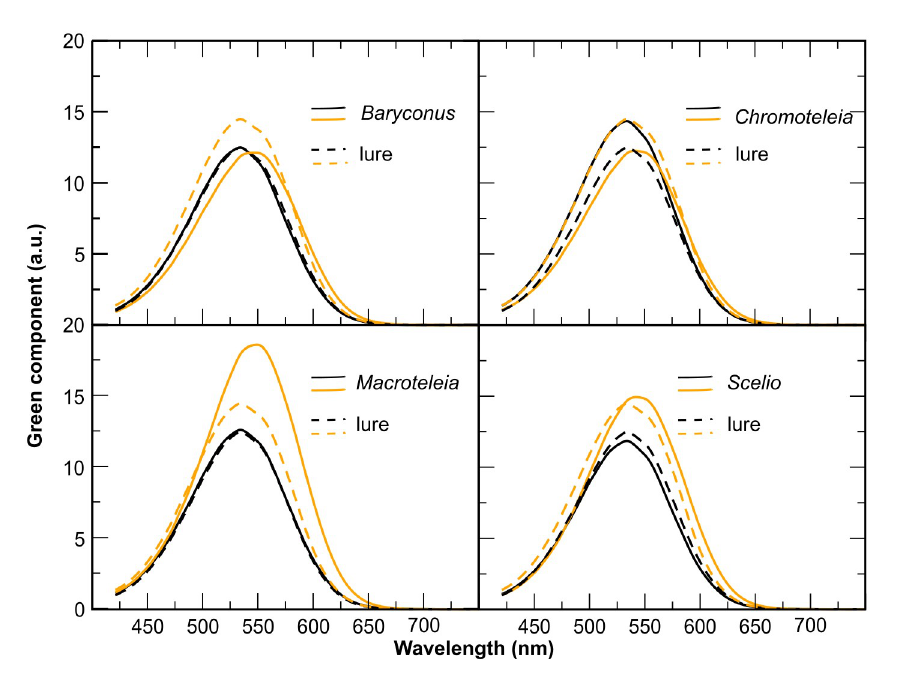
Fig 5. Mean green component of the reflection spectra of both black and orange colors for both the cuticle of each genus and the blend chosen for painting the false prey (painted rice grain). Green component, in arbitrary units (a. u.), of both black (black line) and orange (orange line) colors for the BOB color pattern of four genera of scelionid wasps (solid lines) and the paint chosen for the false prey (dashed